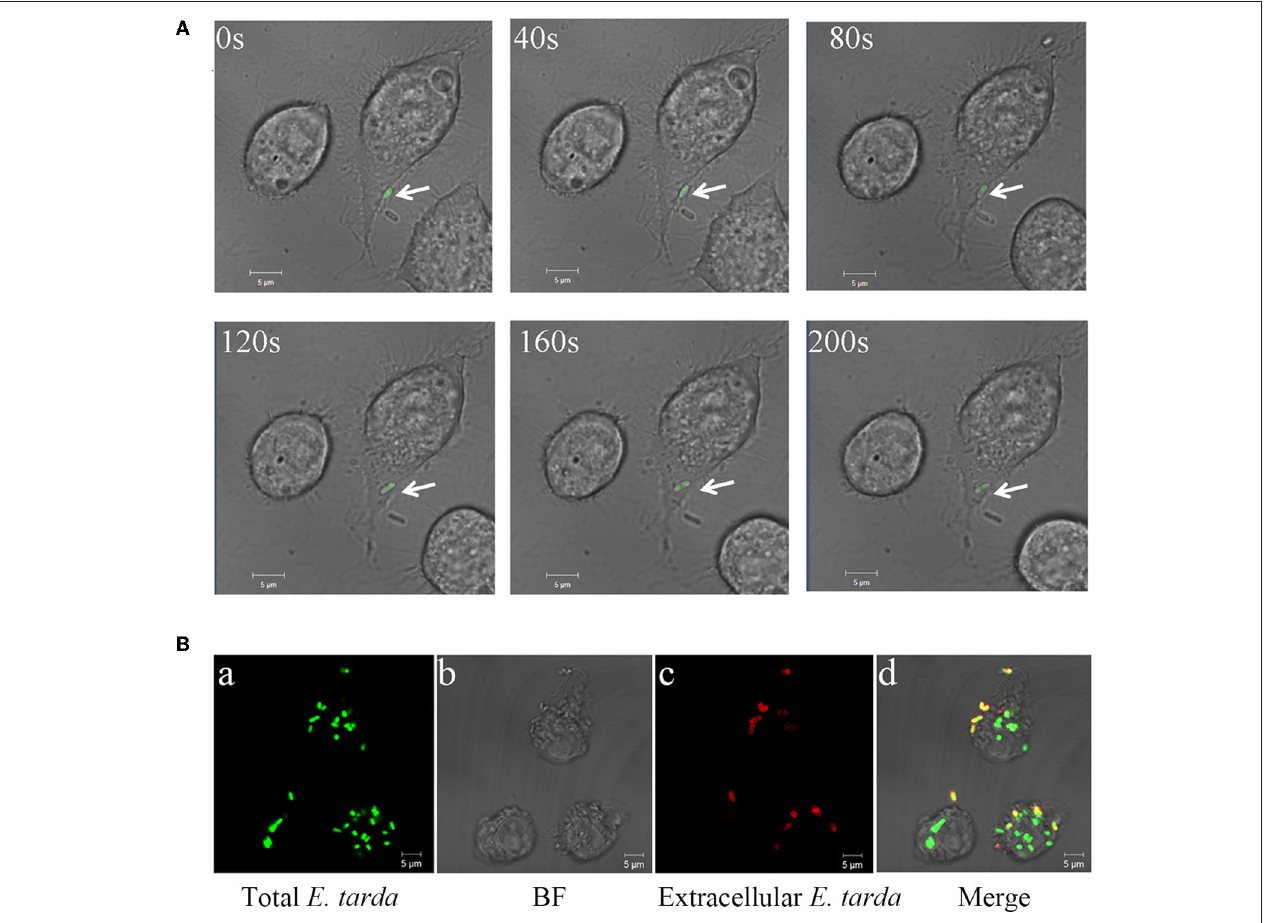
FIGURE 1 | Entry and replication of Edwardsiella tarda in RAW 264.7. (A) RAW264.7 was incubated with E. tarda TX1G, and infection of the bacteria into RAW264.7 was observed continuously for 200s with a confocal microscope. Arrow indicates bacteria. (B) RAW264.7 was infected with TX1G for 2h (a) ; the cells were then fixed, and extracellular TX1G was detected with rhodamine-labeled antibody (c) . d merge of a–c